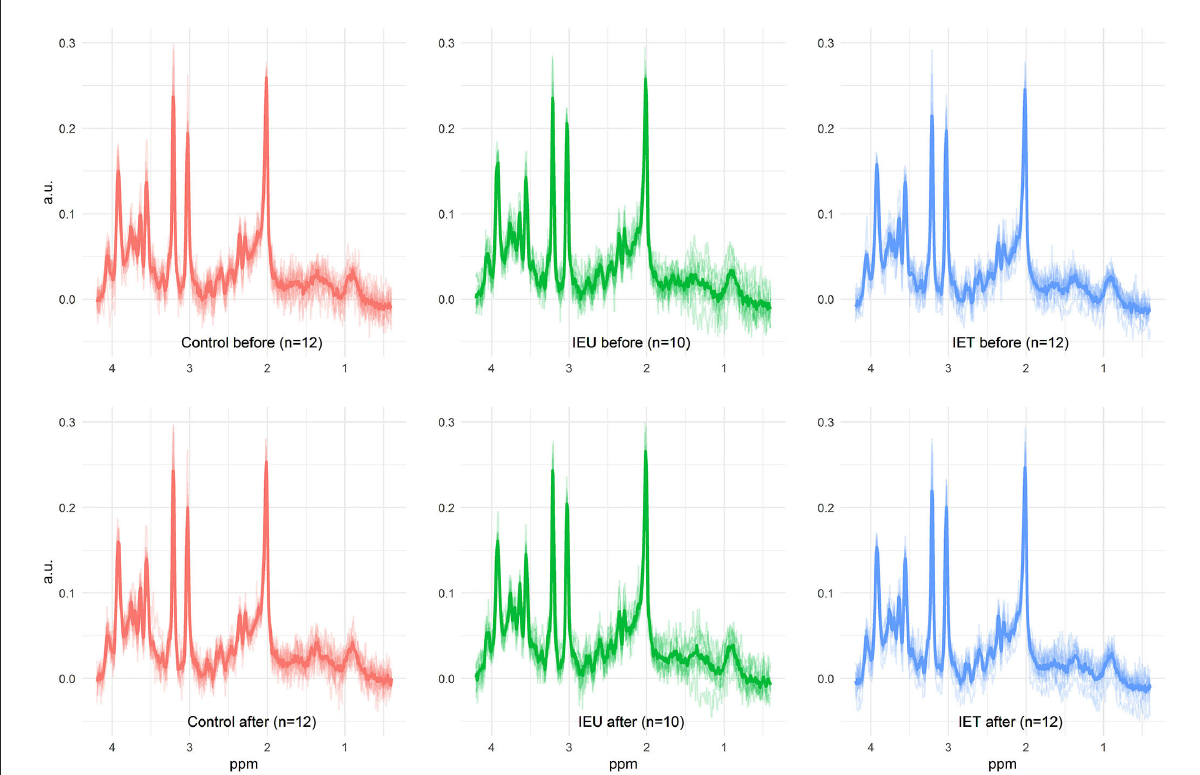
FIGURE1 All measured spectra of the three investigated groups prae and post ketamine administration. In the background, the individual spectra of all dogs are plotted as output from LCModel. The thicker line shows the calculated mean spectrum in each group. This figure illustrates the achieved quality of all 1 H-MRS measurements beyond the quality measures such as SNR and FWHM. In particular, the absence of artifacts can be verified. Metabolite differences described in this study are not visually detectable.